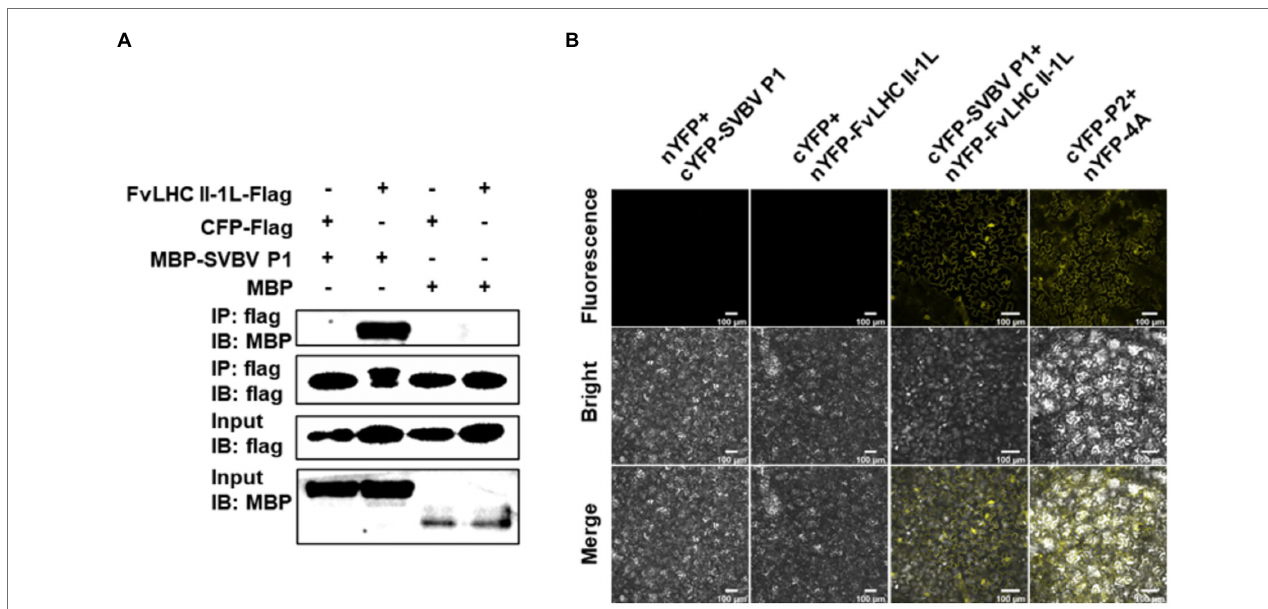
FIGURE 1 | Strawberry vein banding virus (SVBV) P1 interacts with chlorohyll a/b-binding protein of light-harvesting complex II type 1 like of Fragaria vesca (FvLHC II-1L) in vitro and in vivo . (A) Interaction between SVBV P1 and FvLHC II-1L was elucidated using an in vitro pull-down assay. Maltose-binding protein (MBP)-SVBV P1 or MBP was expressed in, and purified from, Escherichia coli BL21(DE3). FvLHC II-1L-Flag or cyan fluorescent protein (CFP)-Flag was expressed in Nicotiana benthamiana leaves and harvested at 3 days post inoculation (dpi). Purified MBP-SVBV P1 or MBP was mixed with plant extract of FvLHC II-1L-Flag or CFP-Flag and pulled down with Flag beads. (B) Interaction between SVBV P1 and FvLHC II-1L was examined using an in vivo bimolecular fluorescence complementation (BiFC) assay. N . benthamiana leaves were co-agroinfiltrated with the following combinations of plasmids: cYFP-SVBV P1 and nYFP-FvLHC II-1L, nYFP-4A and cYFP-P2 (positive control), cYFP-SVBV P1 and nYFP, and nYFP-FvLHC II-1L and cYFP (negative controls). Yellow fluorescent protein (YFP) fluorescence was observed via confocal microscopy at 3 dpi. Bar scale = 100 μ